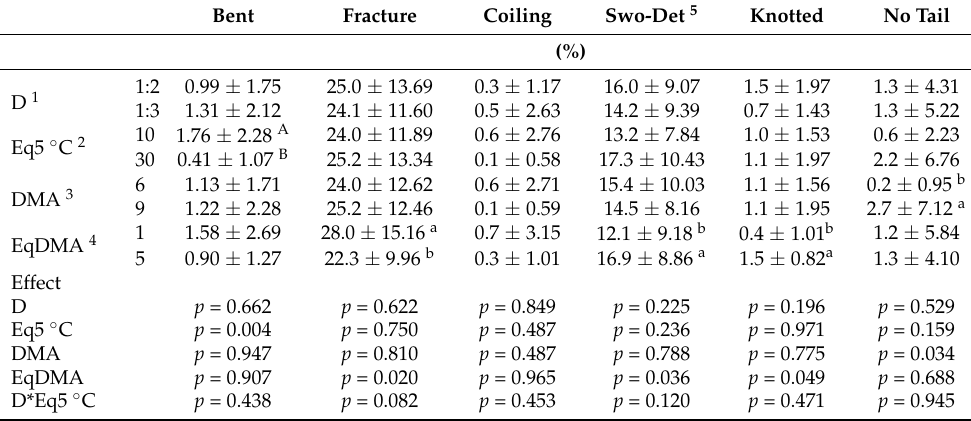
Table 3. Head injuries in frozen common pheasant sperm when using the two levels for each step (dilution, cooling rate, DMA concentration, equilibration time with DMA) of the freezing process in pellets and the step influence on the incidence of these damages (means ±